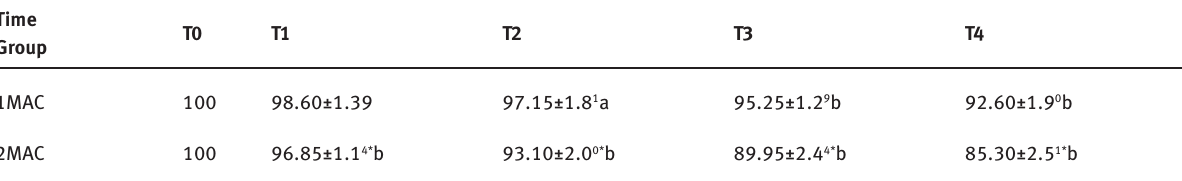
Table 2: Comparison between the two group patients in the relation of sevoflurane inhalation time with EEMG amplitude retention ratio Time